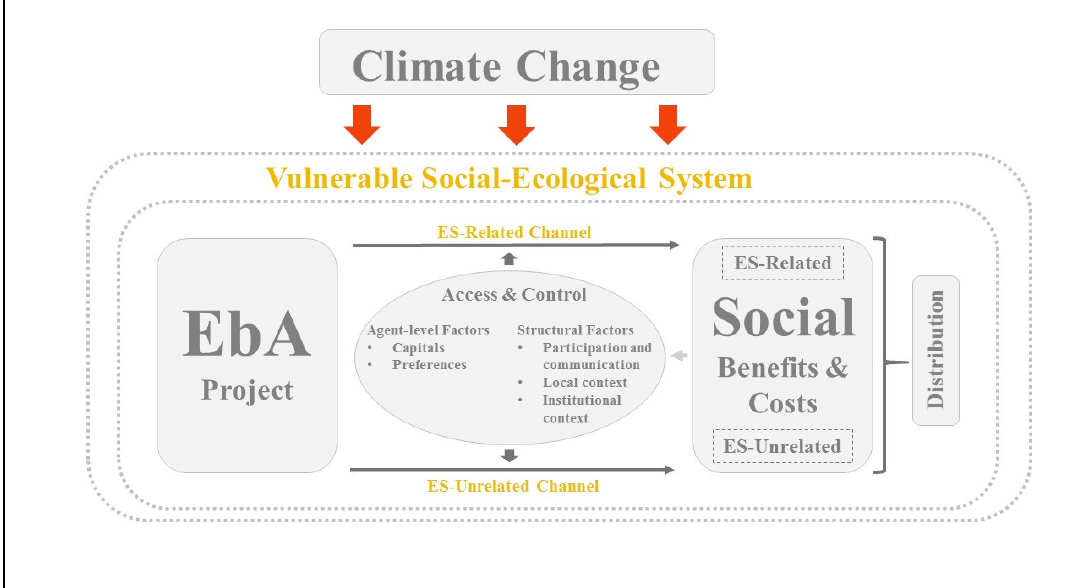
Figure 1. The conceptual framework.